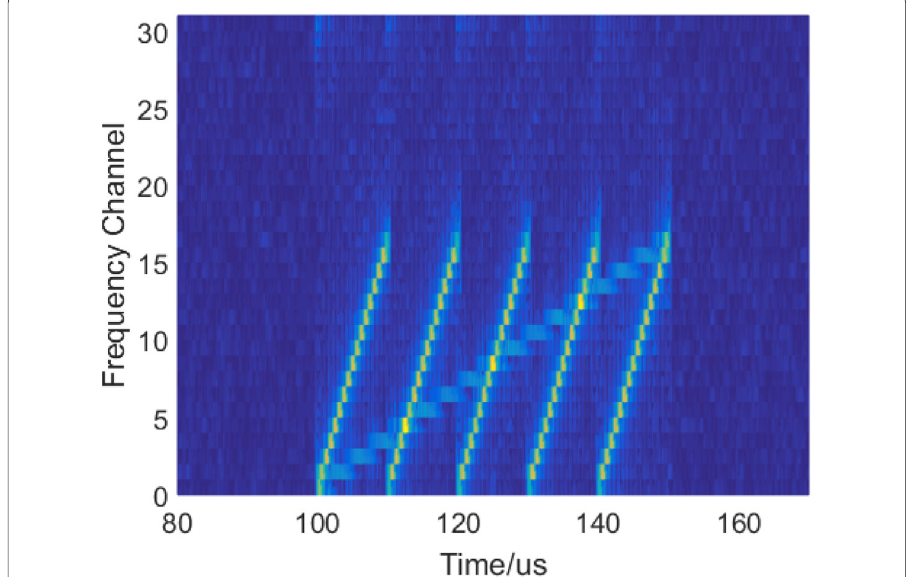
Fig. 3 The STFT result of mixed